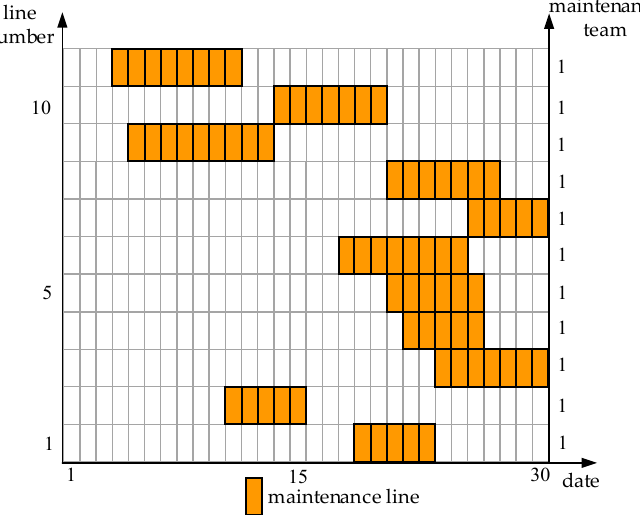
Figure 10. Overhead transmission line maintenance scheduling and team arrangement.